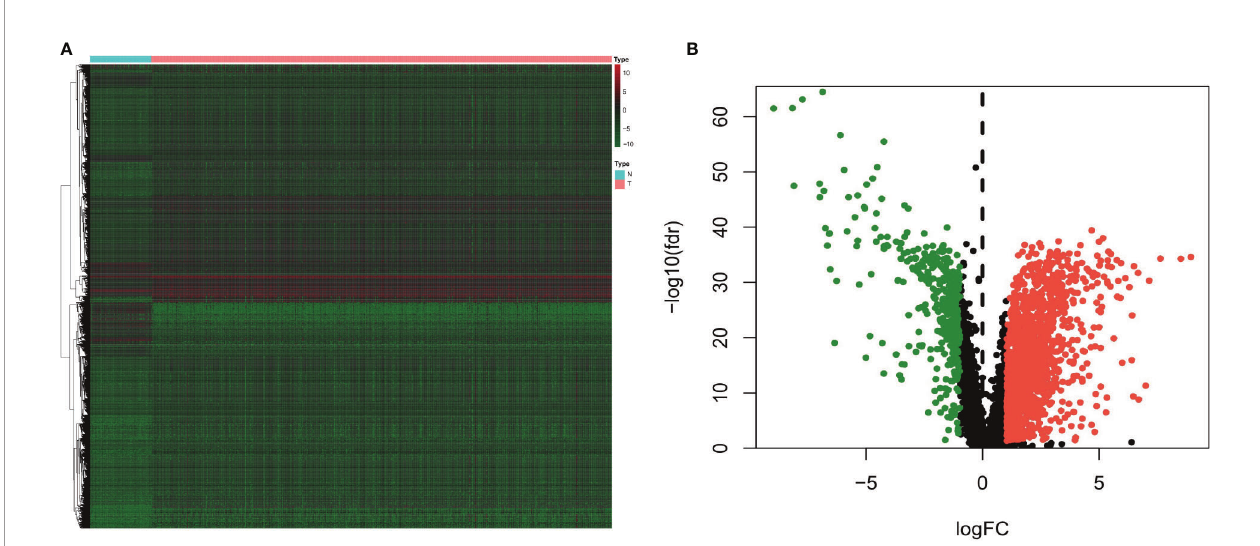
FIGURE 1 | (A) Heatmap and (B) volcano diagram of the Wilcoxon signed-rank test showing the differentially expressed lncRNAs between clear cell renal carcinoma and normal tissue samples. The red, green, and black dots represent the upregulated lncRNAs, downregulated lncRNAs, and no difference,